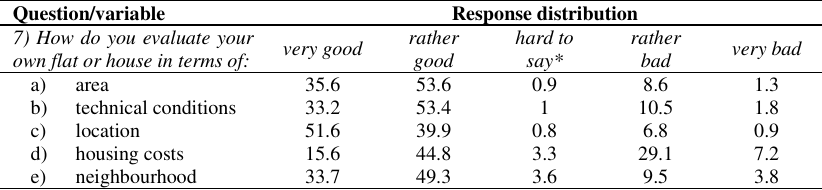
Table 2. Summary statistics for the explanatory variables regarding